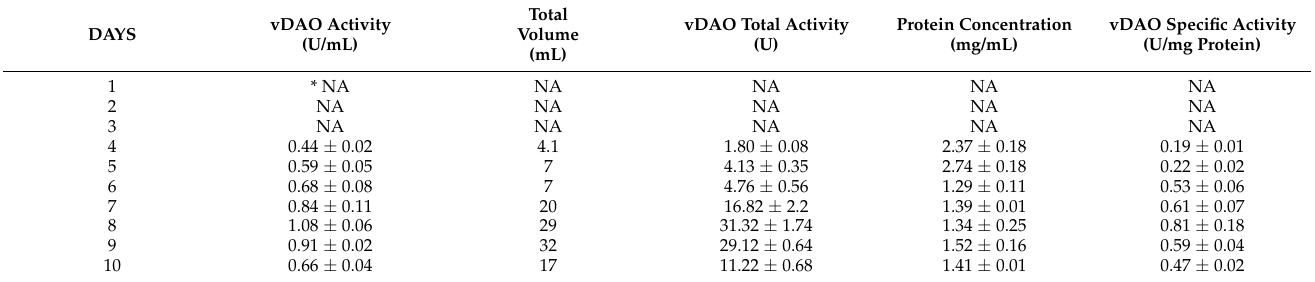
Table 2. Effect of germination time on DAO activity in CDC Amarillo seedlings.